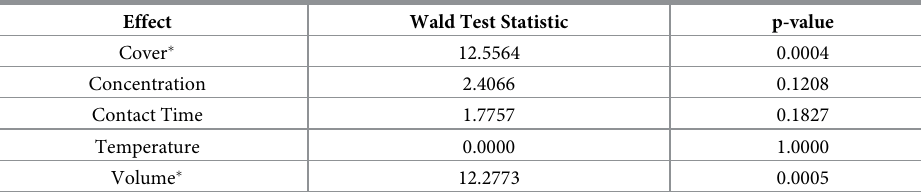
Table 2. Statistical analysis of ability to achieve complete